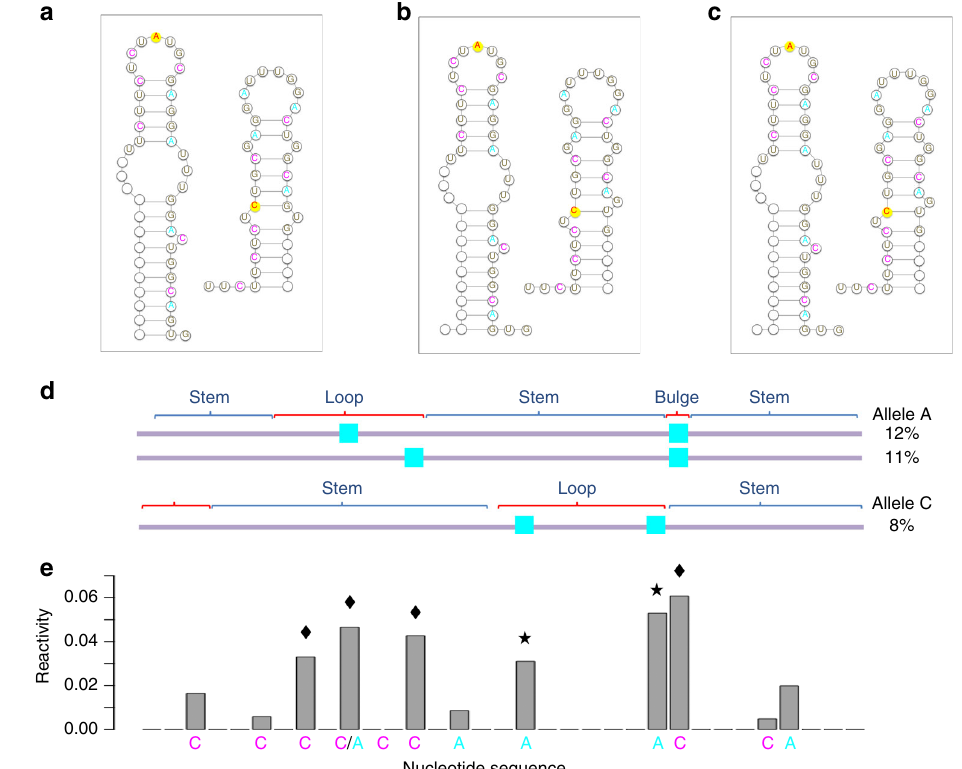
Fig. 2 Structure heterogeneity of the MRPS21 riboSNitch. a Reference structures of alleles A and C as represented in ref. 32 . Representatives of candidate structures selected by SLEQ in mutation mode b and truncation mode c . Nucleotides marked by empty circles are found in regions of no overlap between the reference structures shown in ref. 32 and hence excluded from analysis. Data points with DMS information are highlighted in cyan and magenta for adenines and cytosines, respectively. Red letter over yellow background indicates SNP site. d Top three double-mutation data patterns are shown with their relative frequencies. The top two map to allele A and the third maps to allele C. A general sketch of the reference structure for each allele is shown on top of the patterns to help visualize the agreement between patterns and structures, which drives the selection of similar structures. The higher frequency of patterns supporting A drives the estimation of its higher abundance in the reconstructed ensemble. e Reactivity pro fi le of the heterogeneous sample with both alleles. Pro fi le is aligned with the sequencing reads shown in d and nucleotide labels and colors match the ones shown in a . One can see that average ensemble-based data does not fi t individual structures well. For example, the structure selected for allele A does not support the highly reactive adenines marked by stars, which reside within a stem. Similarly, the structure selected for allele C does not support the highly reactive cytosines marked by